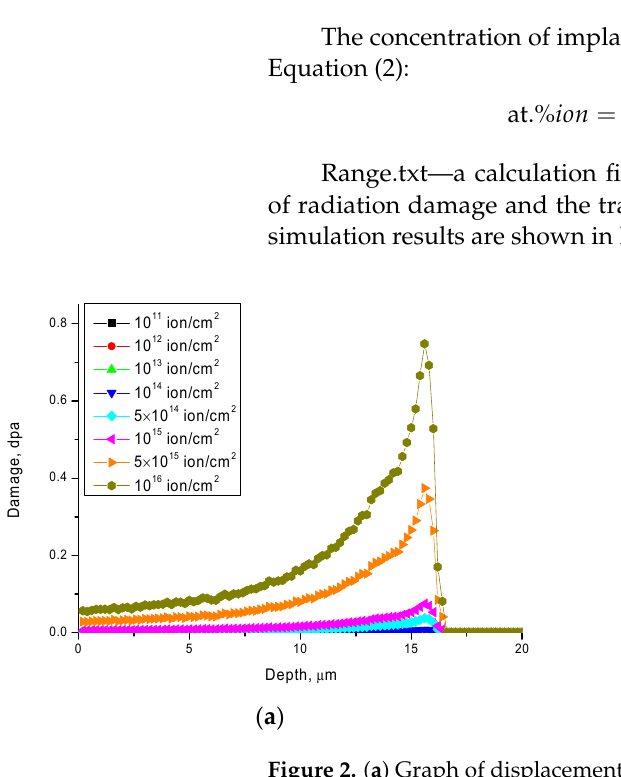
Figure 2. ( a ) Graph of displacements per atom versus radiation fluence; ( b ) graph of the implanted Xe 22+ ion concentration versus irradiation fluence.